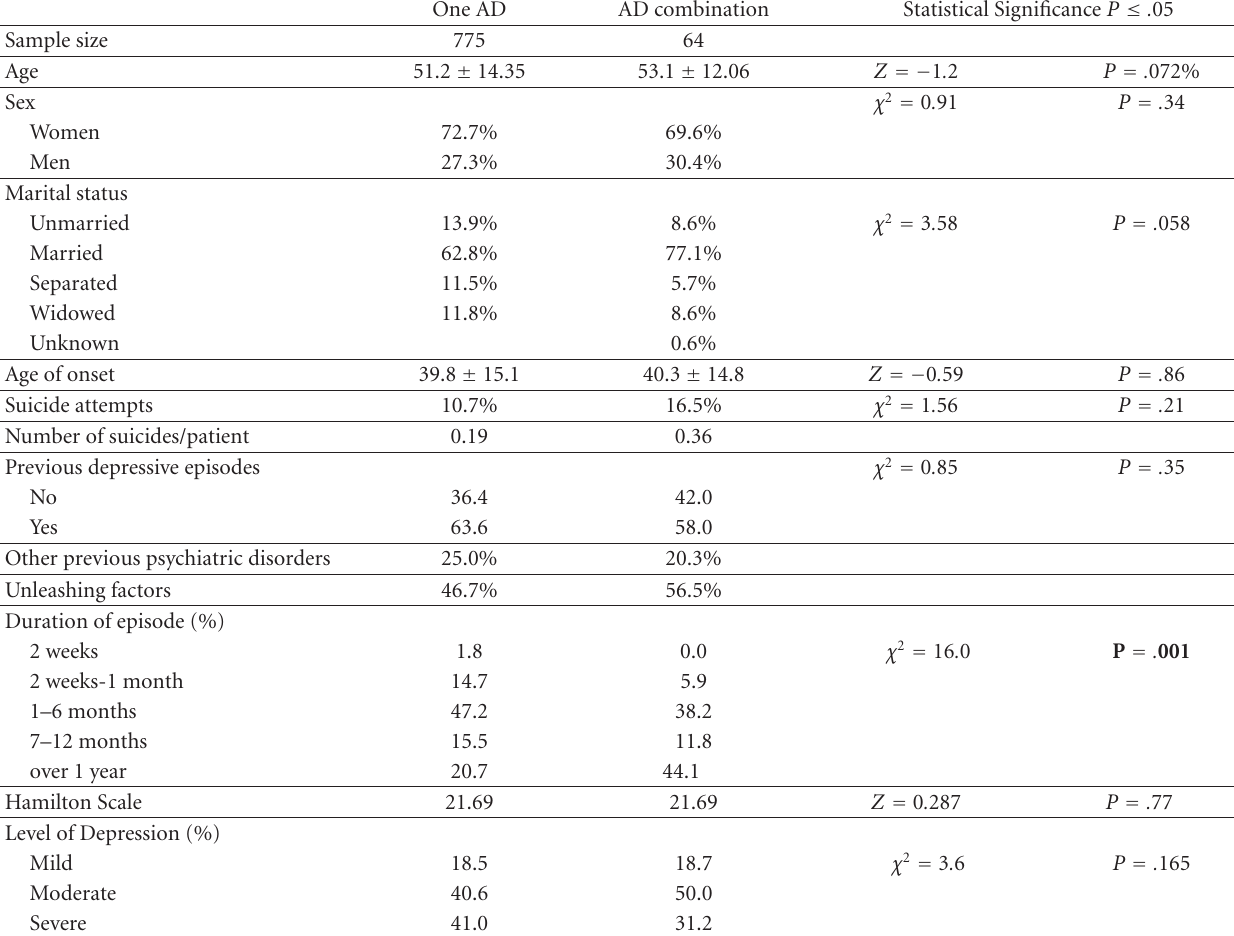
Table 4: Comparative study of patients on one AD versus patients on AD combination.